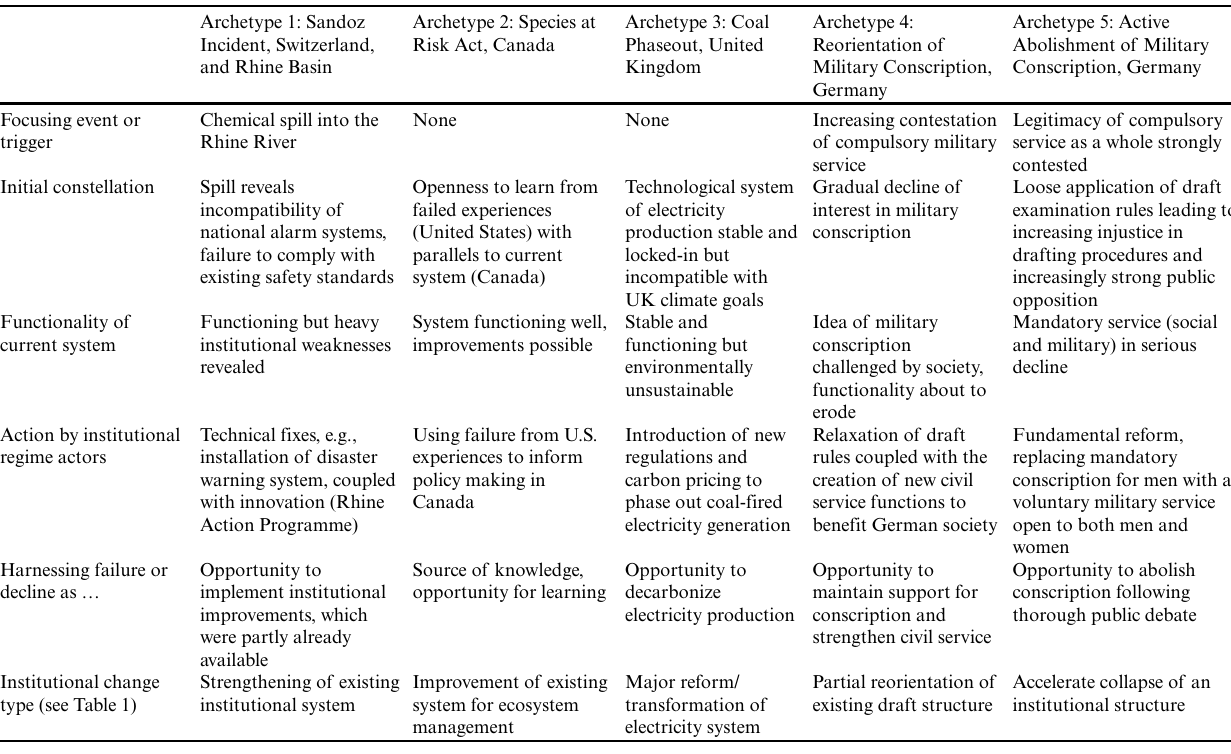
Table 3 . Illustrative cases of archetypes of productive